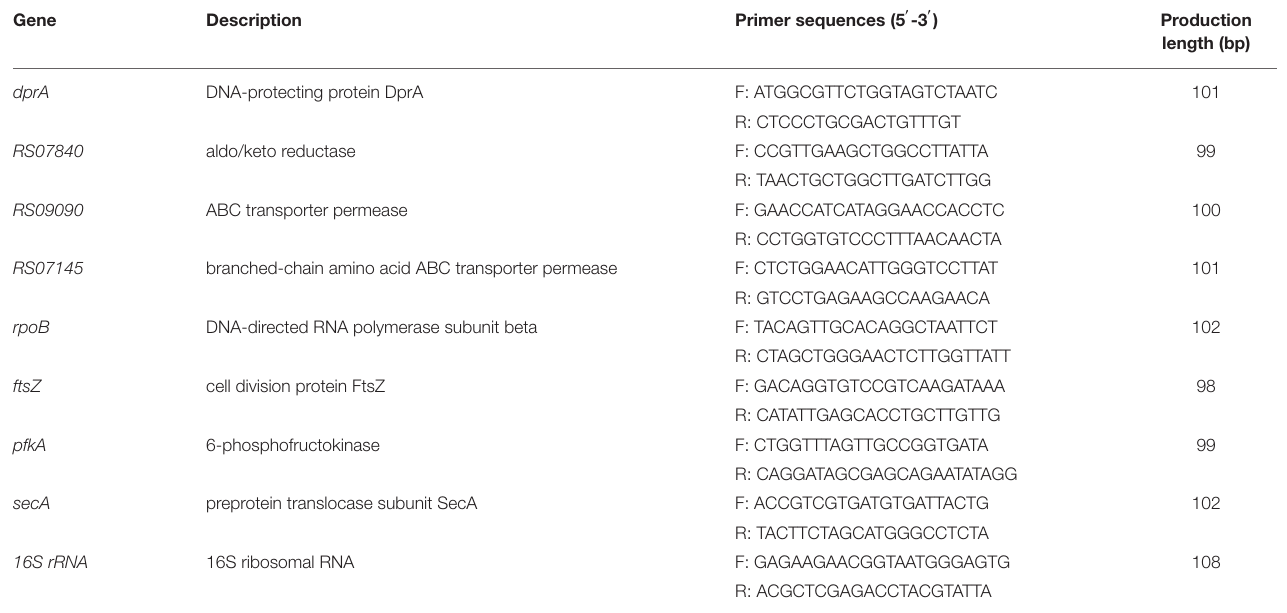
TABLE 1 | Primer sequences for RT-qPCR.